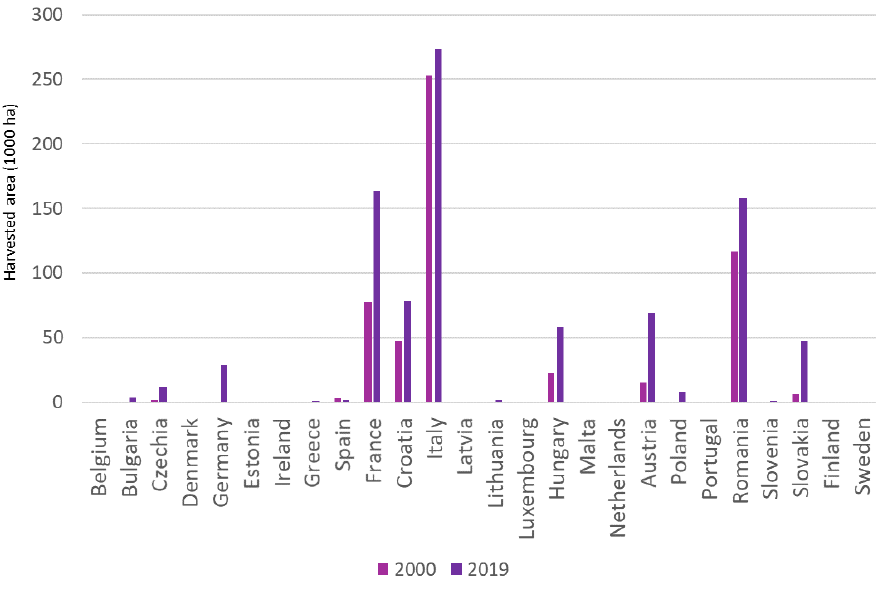
Figure 22. Harvested area of soybean in EU countries in year 2000 and 2019 [46]. Examining the datasets about soybean varieties, the highest number of varieties is in Italy followed by Romania. There are 78 varieties, which are registered simultaneously in two or more countries (Figure 23).